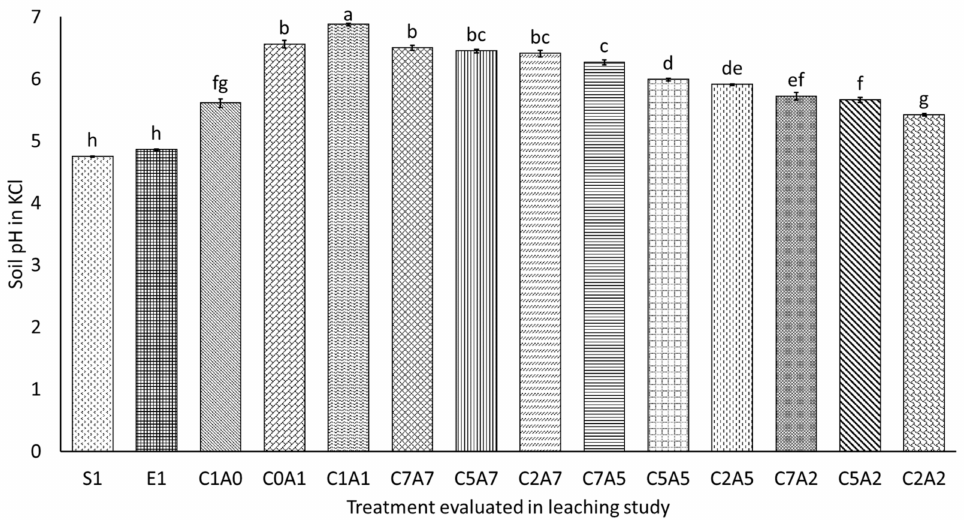
Figure 6. Treatments on soil pH in potassium chloride after thirty days of leaching, where S1: soil only; E1: soil with ERP only; C1: 100% charcoal; C0: 0% charcoal; C7: 75% charcoal; C5: 50% charcoal; C2: 25% charcoal; A1: 100% sago bark ash; A0: 0% sago bark ash; A7: 75% sago bark ash; A5: 50% sago bark ash; A2: 25% sago bark ash. Means with different letter(s) indicate significant differences between treatments according to Tukey’s HSD test at p ≤ 0.05, that is, a > b > c. Bars represent the mean values ± SE.